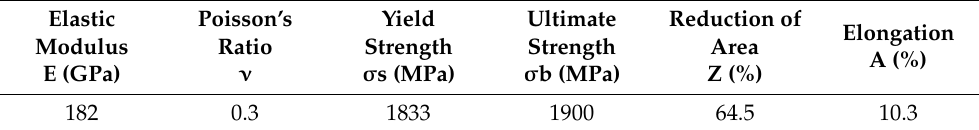
Table 3. Mechanical properties of maraging steel 18Ni